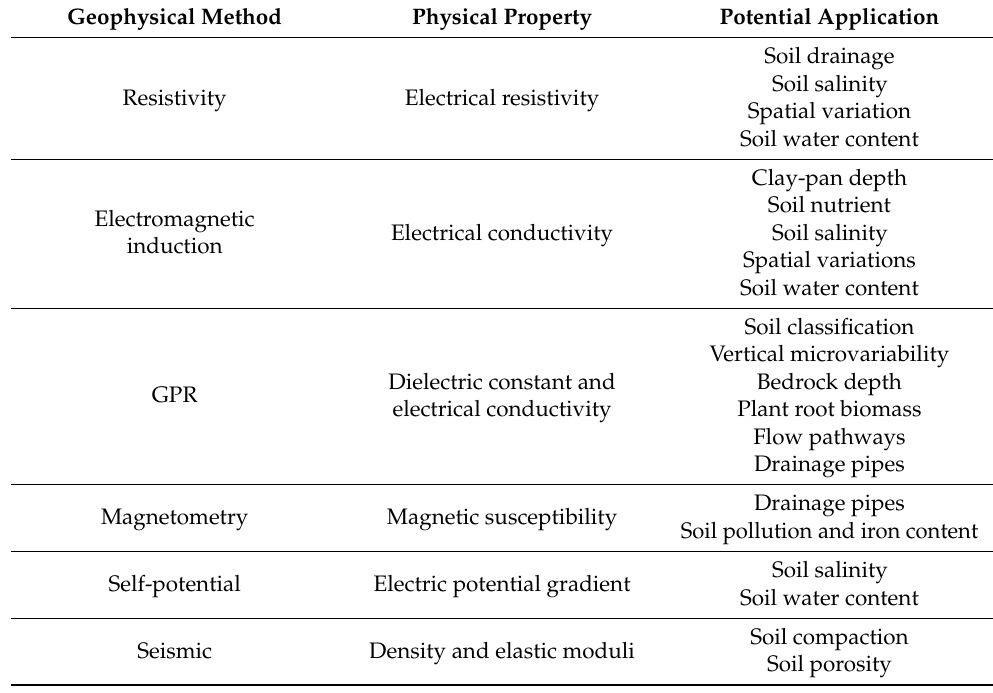
Table 2. The main features of geophysical